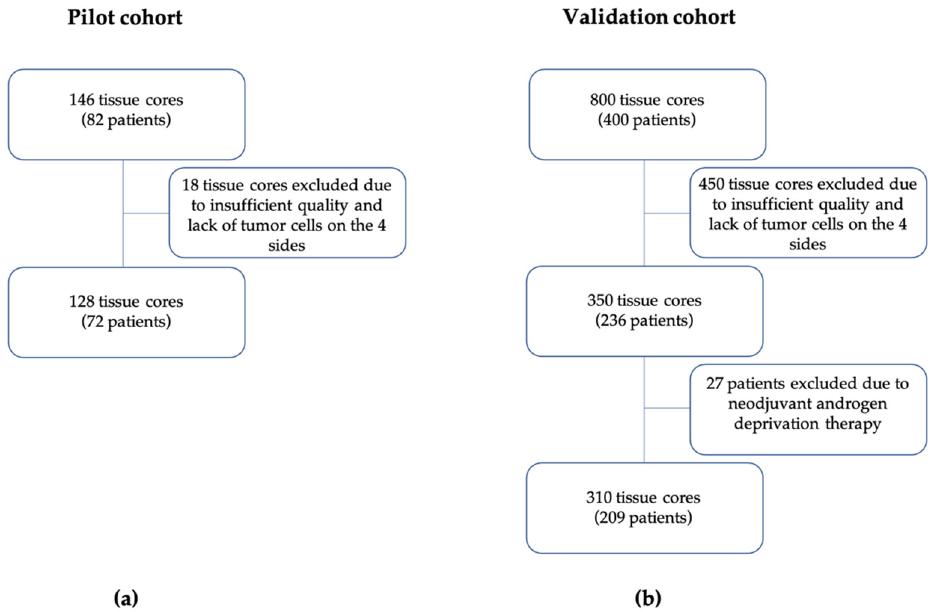
Figure 1. Schematic diagram of patients’ enrollment and exclusion. ( a ) Patients from the pilot. ( b ) Patients from and validation cohort.